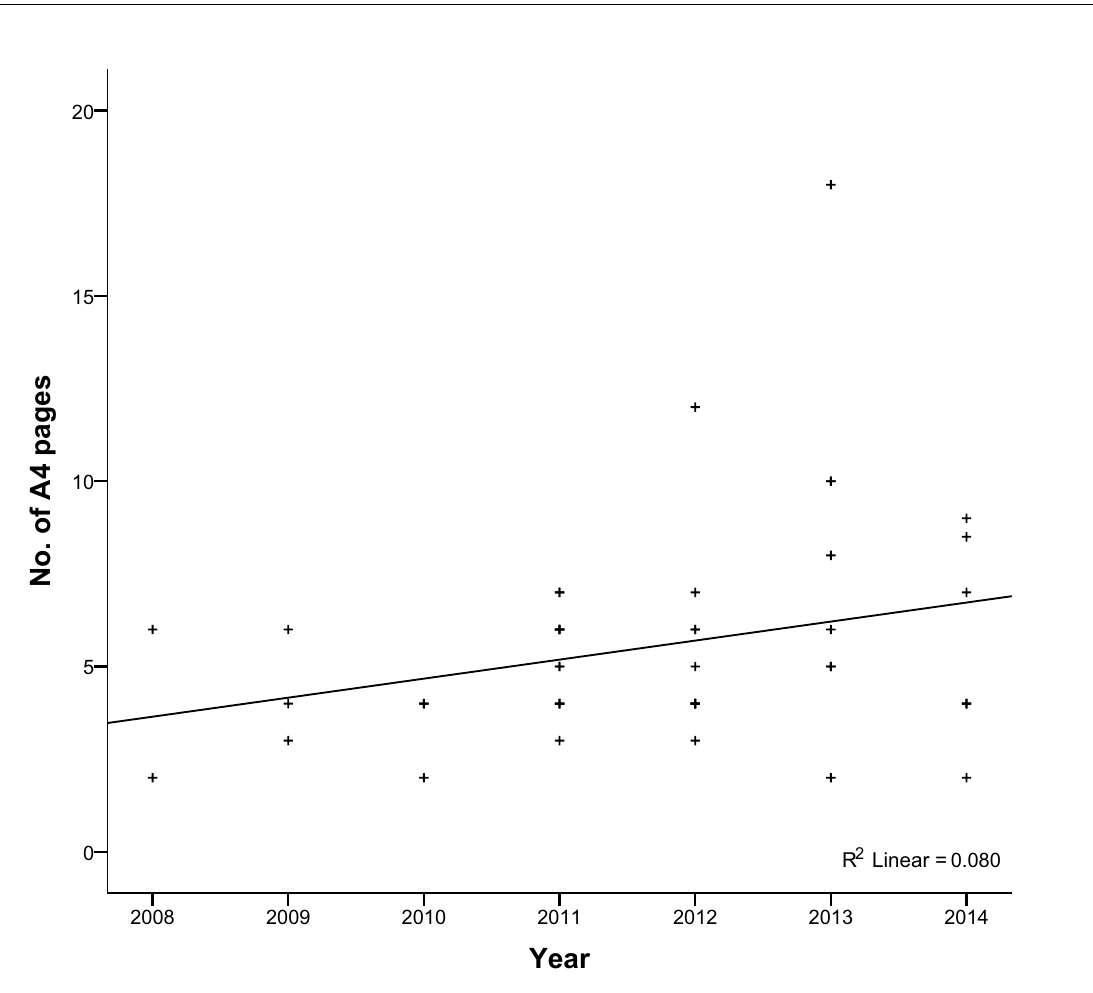
Fig 2. The length of patient information leaflets (n = 46 a ). a The date on four patient information leaflets could not be identified.